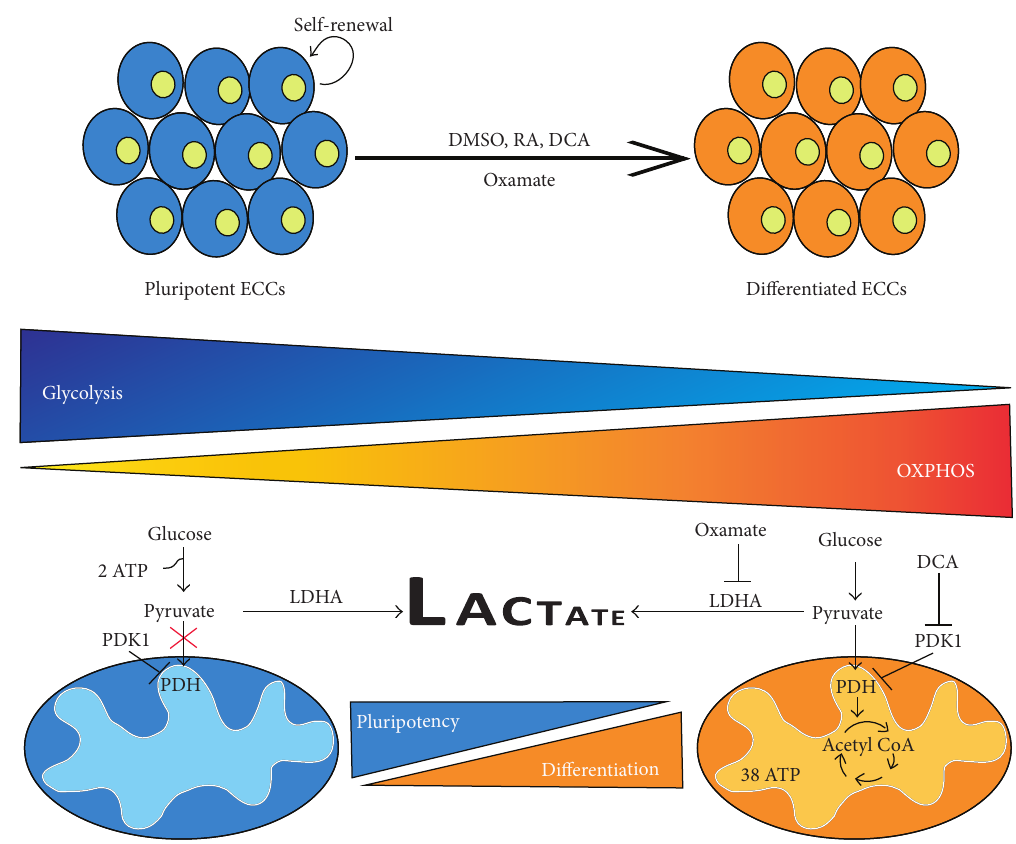
Figure 4: General overview of ECCs differentiation and the metabolic transition associated with the loss of stemness. ECCs can be differentiated towards neuronal and extraembryonic endoderm in the presence of retinoic acid, or cardiomyocytes in the presence of DMSO. With the differentiation process, others and we have observed a metabolic transition from glycolytic metabolism towards oxidative phosphorylation. Moreover, we can induce F9 cell differentiation towards an extraembryonic lineage using dichloroacetate (DCA), a pyruvate dehydrogenase kinase (PDK) inhibitor, or oxamate, a lactate dehydrogenase A (LDHA) inhibitor, which would indicate that the metabolic status of a cell determines whether it will remain pluripotent or if it will differentiate towards a specific